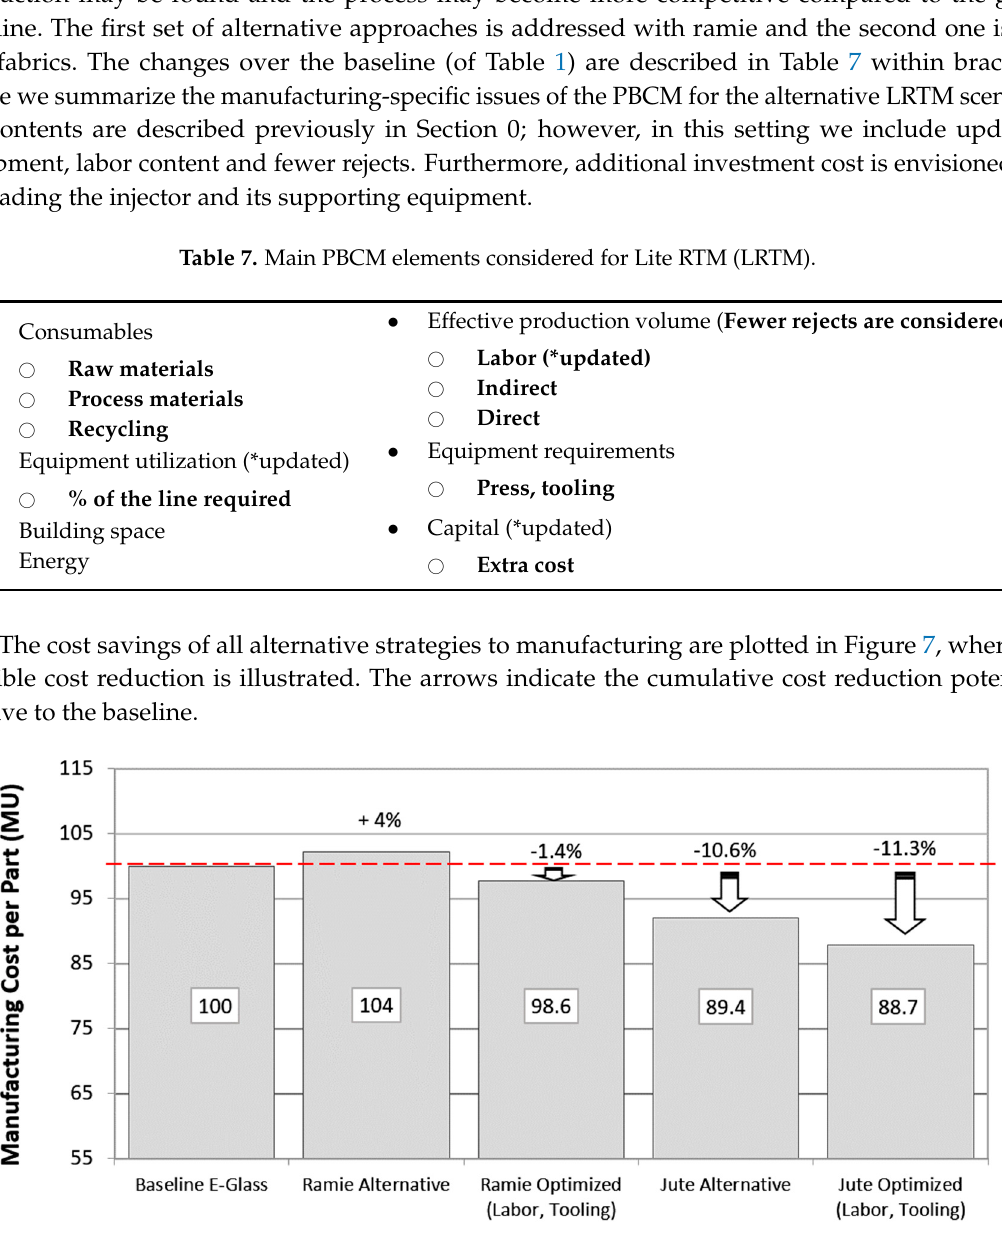
Figure 7. Cumulative cost reduction potential from optimized approaches at 300 parts/year.